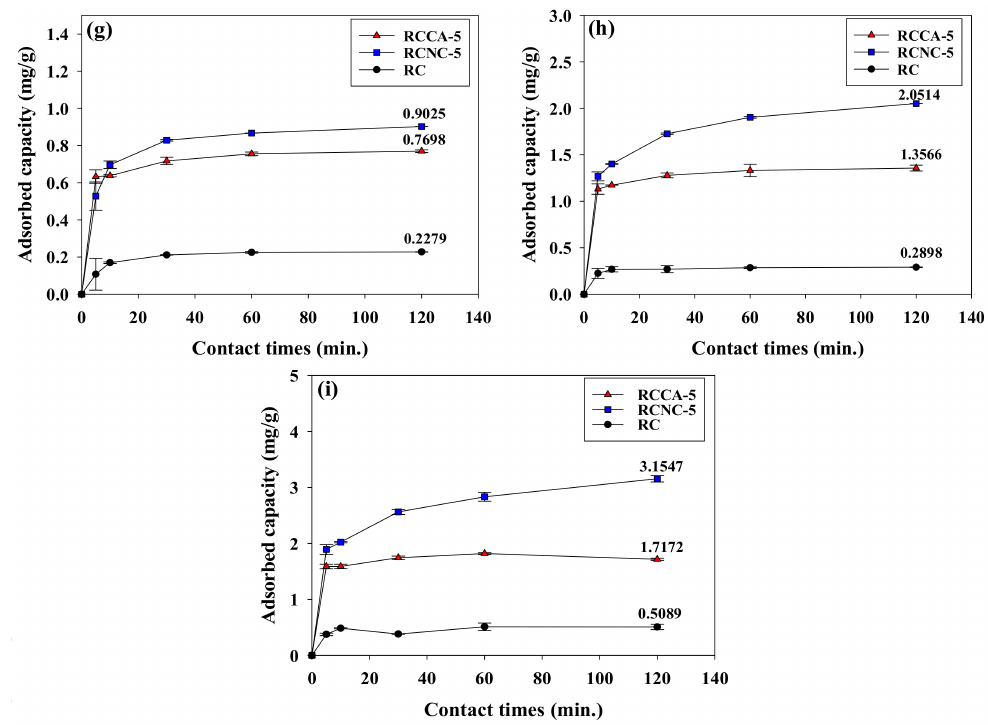
Figure 7. Cadmium adsorption by the manufactured composites (RCCA-5, RCNC-5) and RC, according to various pHs, times, and cadmium concentrations: ( a ) 10 ppm at pH 4, ( b ) 25 ppm at pH 4, ( c ) 50 ppm at pH 4, ( d ) 10 ppm at pH 5, ( e ) 25 ppm at pH 5, ( f ) 50 ppm at pH 5, ( g ) 10 ppm at pH 6, ( h ) 25 ppm at pH 6, and ( i ) 50 ppm at pH 6.